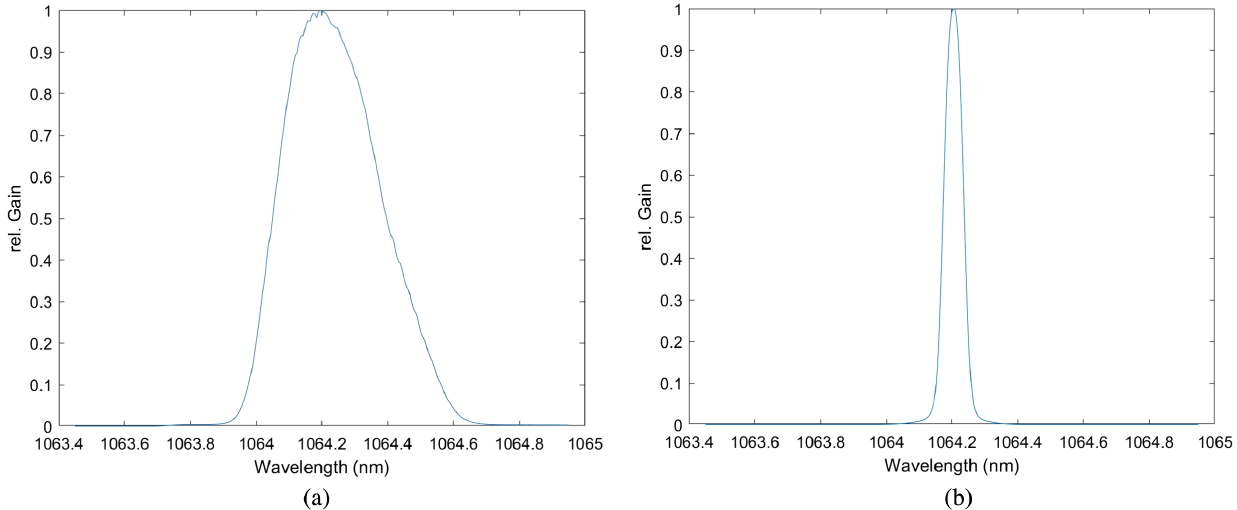
FIG. 22. (a) Normalized small-signal gain of the regenerative amplifier. (b) Measured spectrum of the drive laser before the second harmonic generation